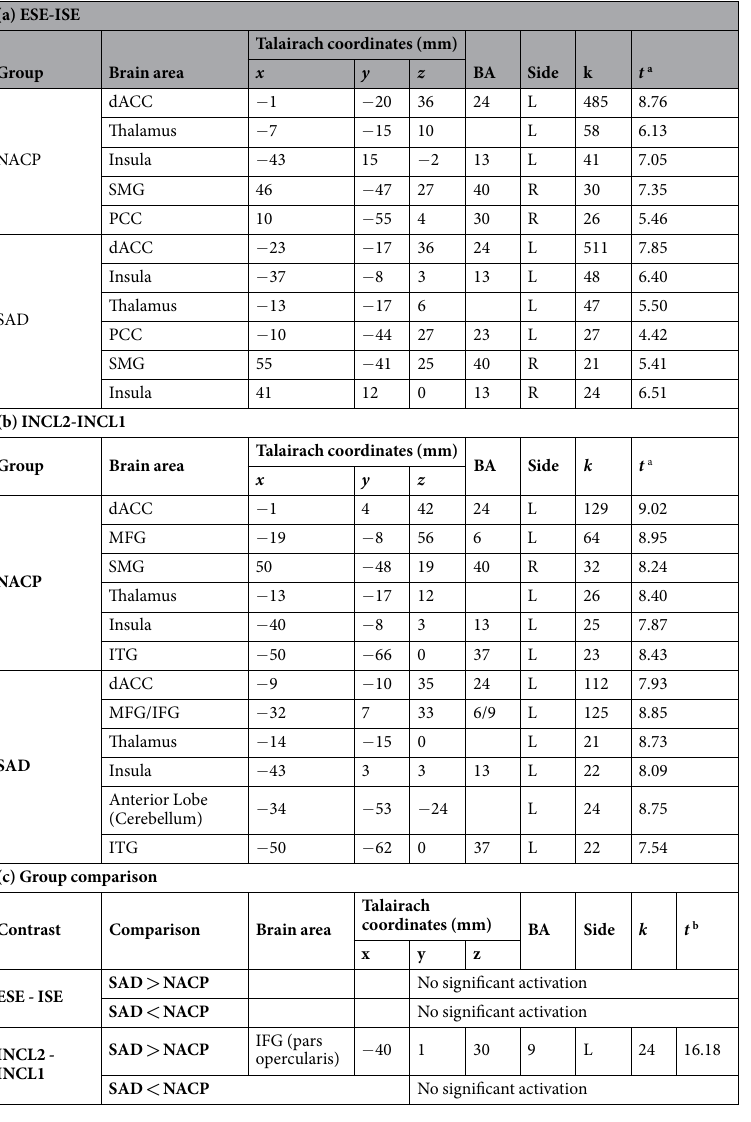
Table 2. Significant brain activations for (a) social exclusion as compared to implicit exclusion ( ESE – ISE ) among matched nonanxious control participants (NACP) and individuals with qualifying for the diagnosis of Social Anxiety Disorder (SAD); (b) re-inclusion after social exclusion as compared to first inclusion ( INCL2 – INCL1 ) in each group; (c) group comparisons during social exclusion and re-inclusion. Notes. x, y, and z are Talaraich stereotaxic coordinates of peak-height voxel-cluster activations. BA = Brodmann’s area; dACC = dorsal anterior cingulate cortex; IFG = inferior frontal gyrus; ITG = inferior temporal gyrus; k = cluster size in units of contiguous voxels; L = left hemisphere; MFG = middle frontal gyrus; PCC = posterior cingulate cortex; R = right hemisphere; SMG = supramarginal gyrus. Threshold set at p < 0.001, p-values are corrected for multiple comparisons using a Monte-Carlo simulation (iterations = 10,000) cluster size threshold adjustment, with a minimum cluster size of 20 contiguous voxels for the one-sample t -tests and 16 contiguous voxels for the two-sample t -tests. a Value for t (22); b Value for t